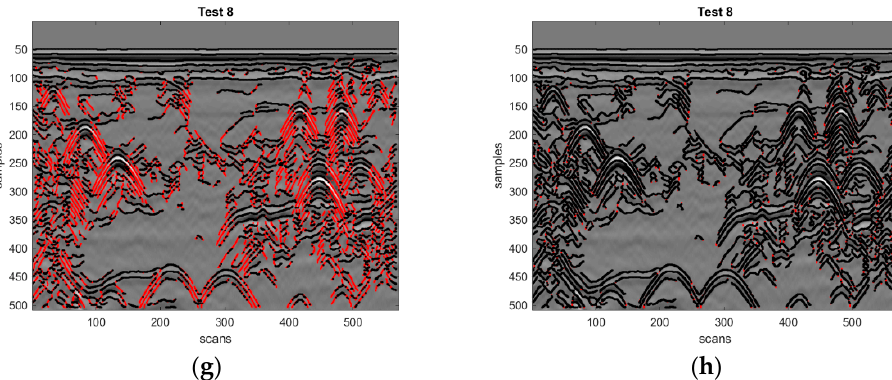
Figure 7. Edge pixel removal results obtained for Radargram #8 by using search zones (a)-(h) depicted